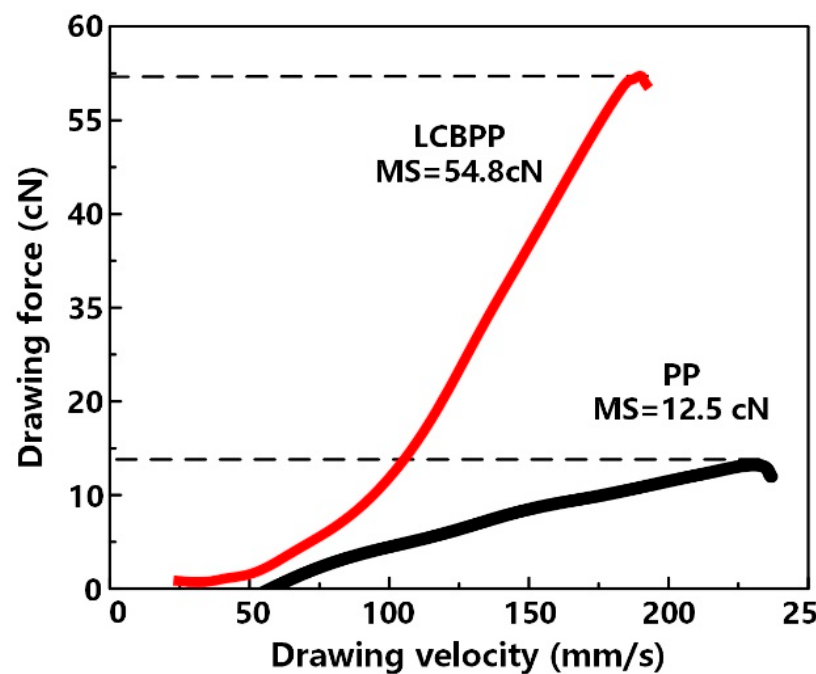
Figure 2. Melt strength test results for PP and LCBPP.